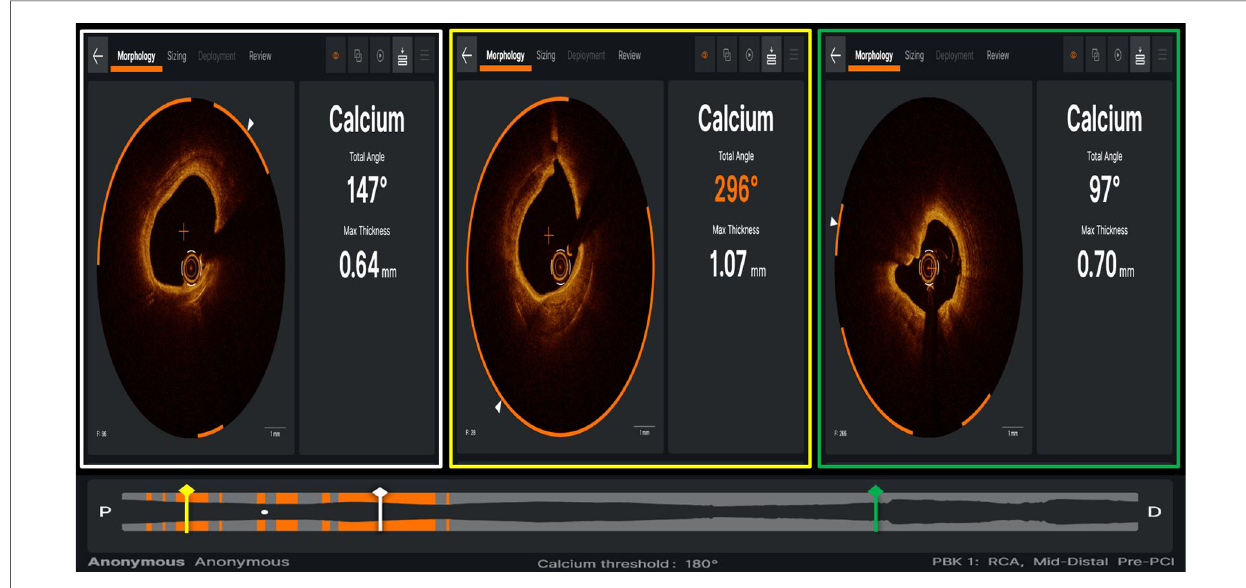
FIGURE 7 Case example of optical coherence tomography applying ultreon software (Abbott) for automated detection of calcium burden and distribution, expressed by calcium arc (orange arcs in the three panels) and maximal thickness (de fi ned by white arrowhead on each OCT